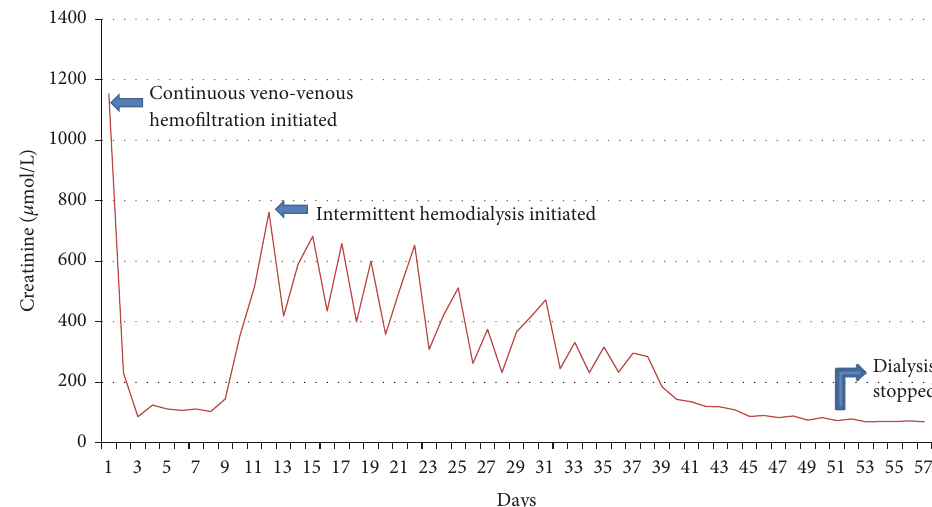
Figure 1: Graph showing creatinine levels from time of presentation until resolution of acute kidney injury.